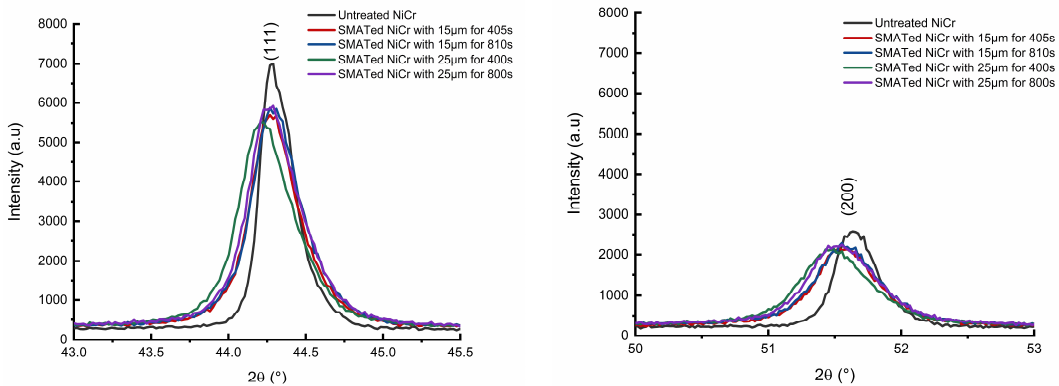
Figure 7 . Zoomed images of the XRD patterns of Figure 6.